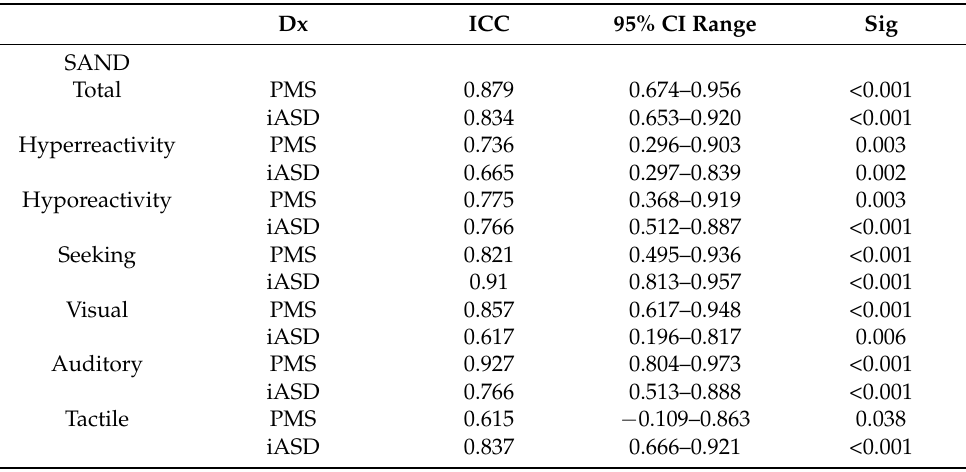
Table 4. Stability of SAND scores over 12